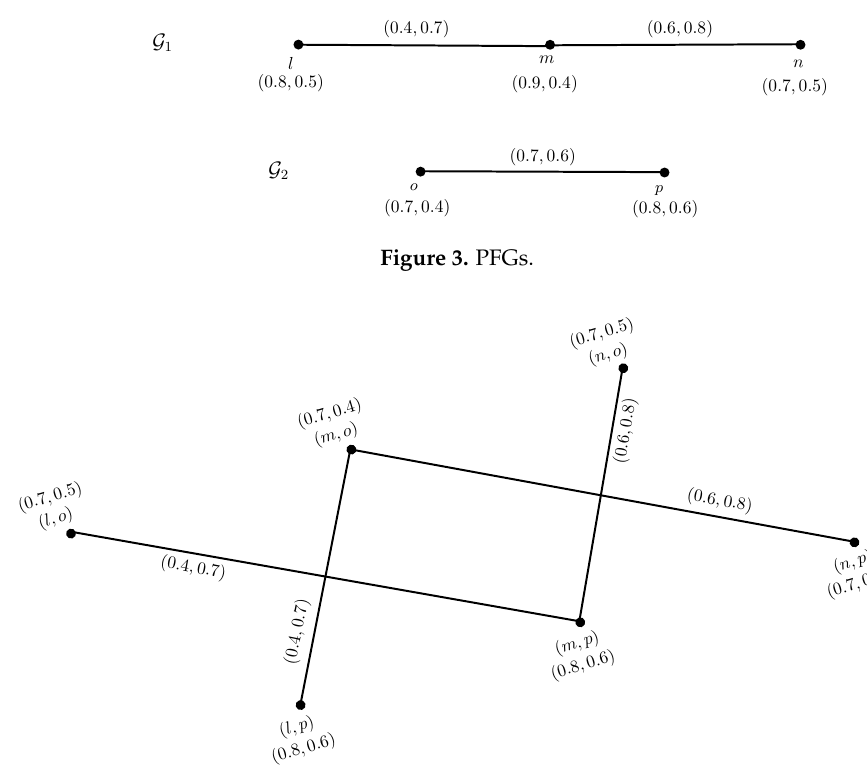
Figure 4. Direct product of two